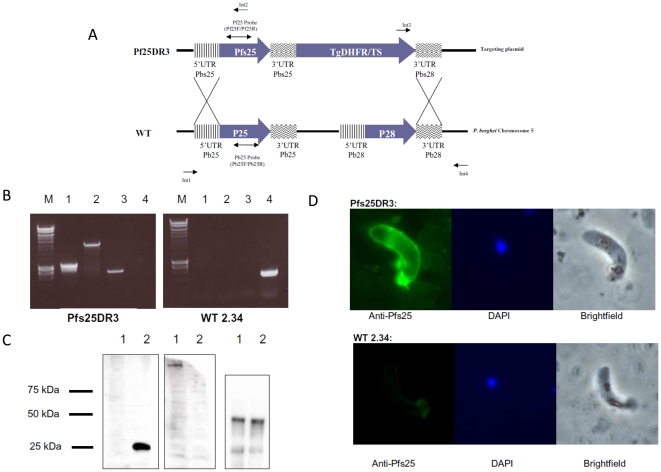
Generation and phenotypic analysis of Pfs25DR3.
(A) Schematic representation of the construction of Pfs25DR3. The targeting plasmid was linearized by restriction digestion, and DNA was transfected into P. berghei ANKA 2.34. The P. berghei ORFs P25 and P28 were replaced with the P. falciparum gene sequence of Pfs25 and the selectable marker cassette (TgDHFR/TS). (B) Diagnostic PCR on cloned transgenic Pfs25DR3. (M: 500 bp marker; 1: 5′ integration, oligos Int1+Int2; 2: 3′ integration, oligos Int3+Int4; 3: Pf25 presence, oligos Pf25F+Pf25R; 4: Pb25 presence, oligos Pb25F+Pb25R. (C) Western blot analysis of Pfs25DR3 ookinetes. Purified ookinetes (5×107 per lane) were hybridized with anti-Pfs25/GFP serum from Ad-MVA immunized mice. Loading control was carried out on stripped nitrocellulose membrane with anti-TAT-1 antibody at 1∶10,000 (primary), and anti-mouse IgG at 1∶10,000 (secondary). Lane 1: P. berghei WT 2.34 ookinetes; Lane 2: P. berghei Pfs25DR3 ookinetes. (D) Expression and localization of Pfs25 in the Pfs25DR3 transgenic parasite was confirmed via immunofluoresence assay on PFA fixed ookinetes.